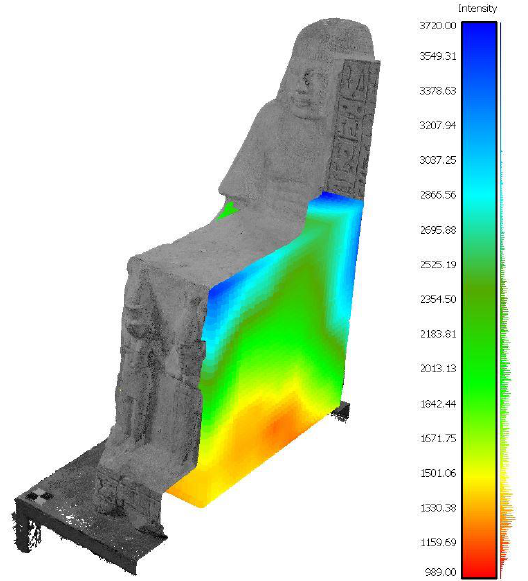
Table 2. The volumes of the statue for each range of